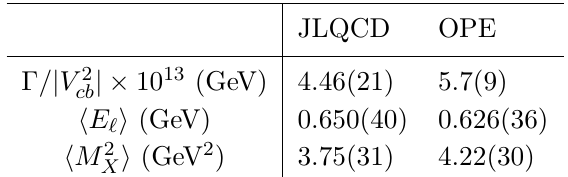
Figure 19 . Differential moment L 1 ( q 2 ) in the various channels. The plots show the comparison between OPE and ETMC data.